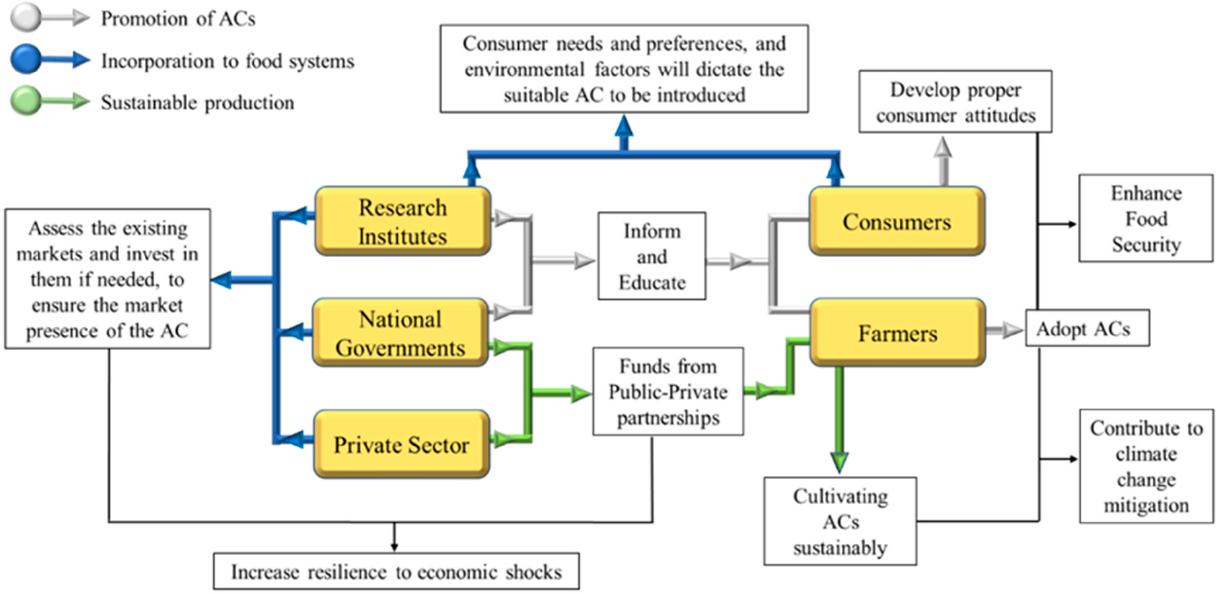
Figure 2. Highlights of the three stages of introducing ACs. All the actors (yellow color) of the ACs value chain and their key interactions are briefly depicted in the figure. The actions and interactions of each stage are depicted with different colors (white, blue, and green). As the three stages are not necessarily successive, actions and interactions of the actors from different stages could be simultaneous.